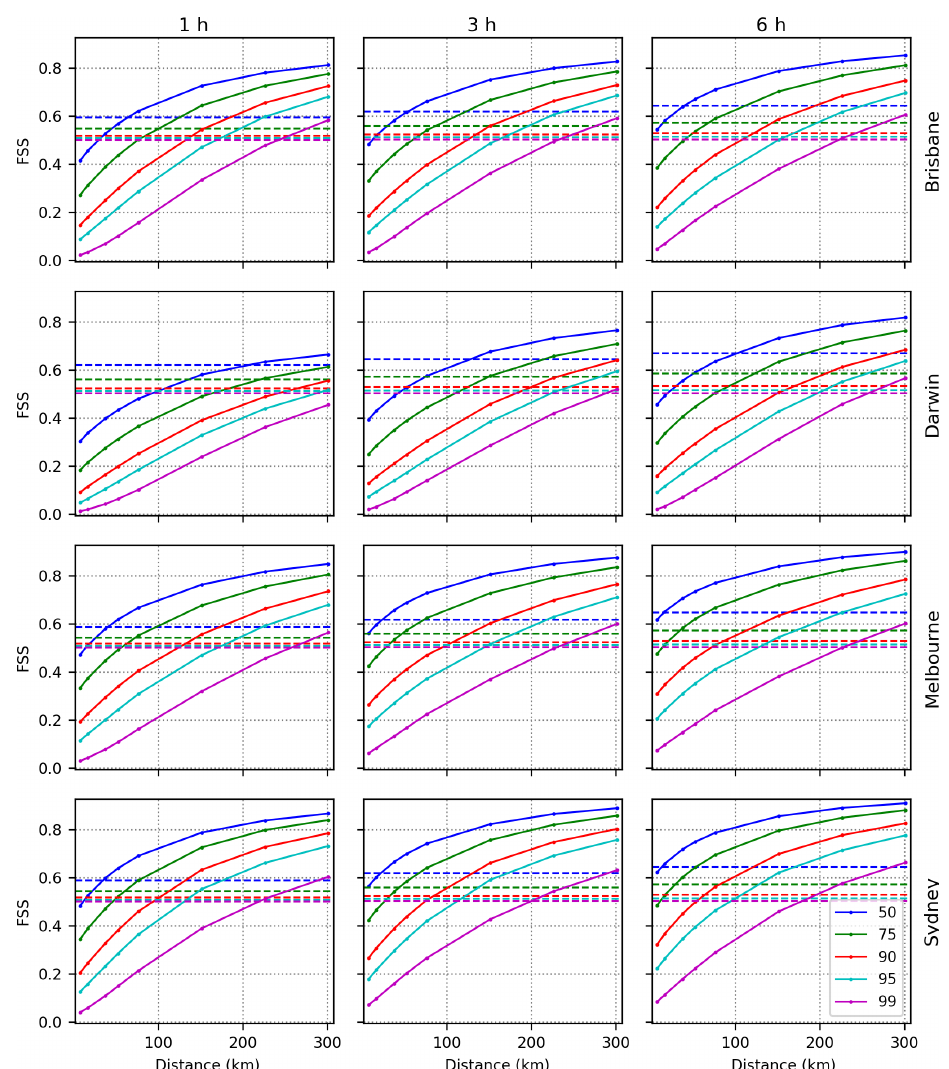
Figure 5. Mean FSS as a function of neighbourhood distance for rainfall above quantile thresholds (indicated by colours) at various locations (rows) and accumulations (columns). The dashed horizontal lines indicate the target or uniform (FSS target or FSS uniform ) skill for each threshold as specified by Roberts and Lean